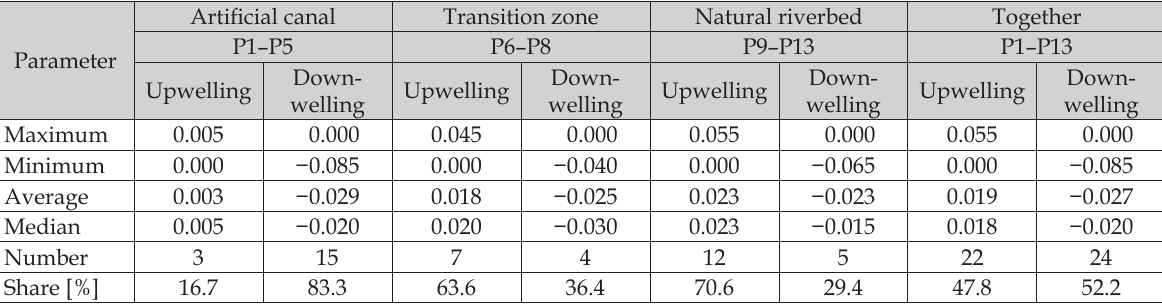
Table 6. Statistical analysis of the results of the hydraulic gradient research in the bottom of the Moszczenica for the canal, transitional zone and the natural